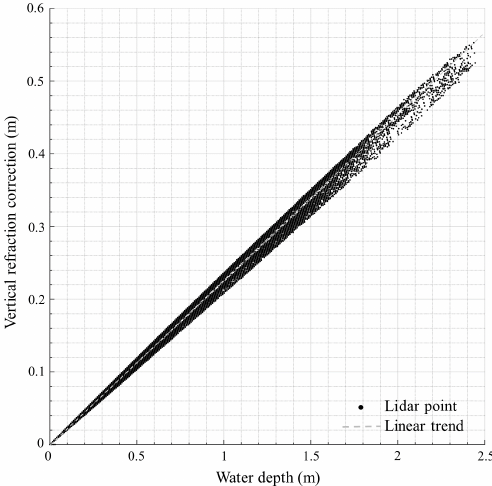
Figure 6. Vertical adjustment of the refracted lidar points from the flood channel transect (see location in Fig.